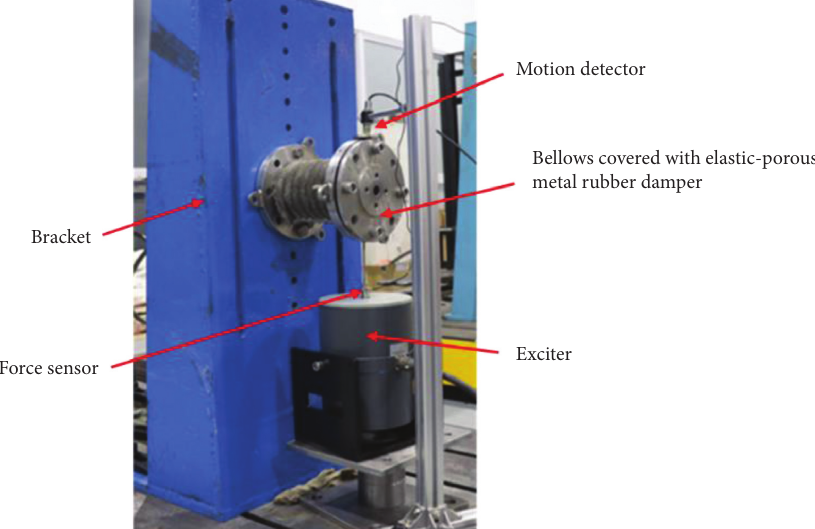
Figure 3: Dynamic experimental test device for the bellows structure covered with an elastic-porous metal rubber damper.